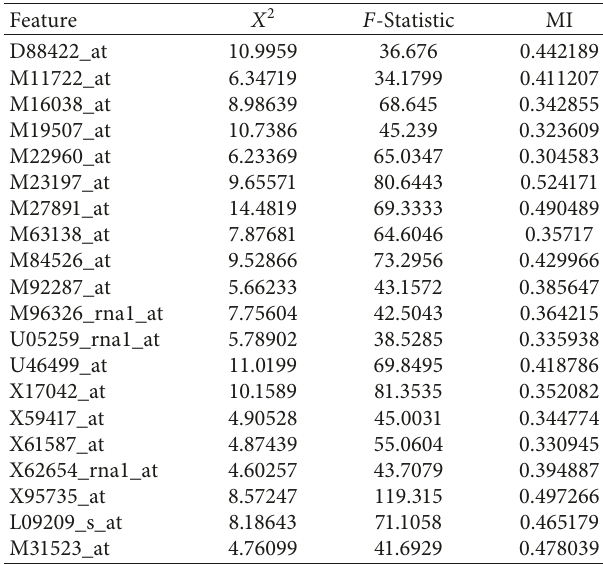
Table 2: Feature score table (FST) for the leukemia dataset.